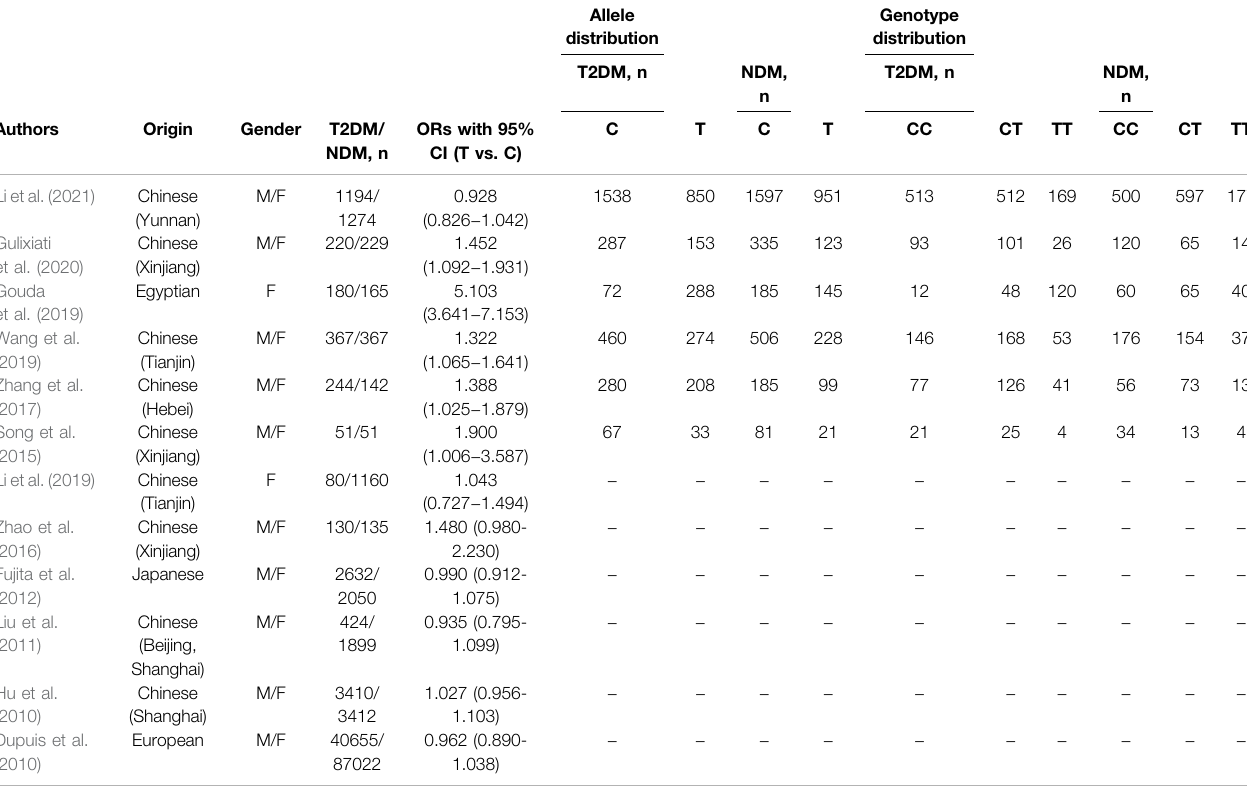
TABLE 1 | Characteristics of each study included in this meta-analysis.